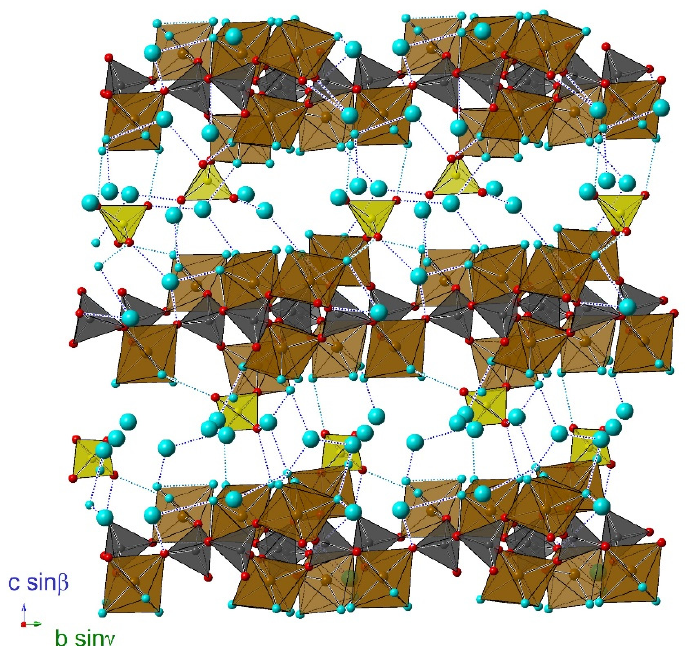
Figure 3. Detail of the crystal structure of bohuslavite showing interlayer H 2 O groups with dotted lines indicating O ··· O distances shorter than 3 Å. Same symbols as in Figure 2. Interlayer H 2 O groups are shown as light blue circles larger than those used for Fe-bonded H 2 O.